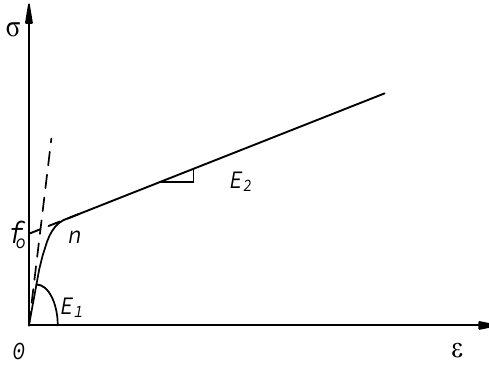
Figure 8. Typical stress–strain relationship.